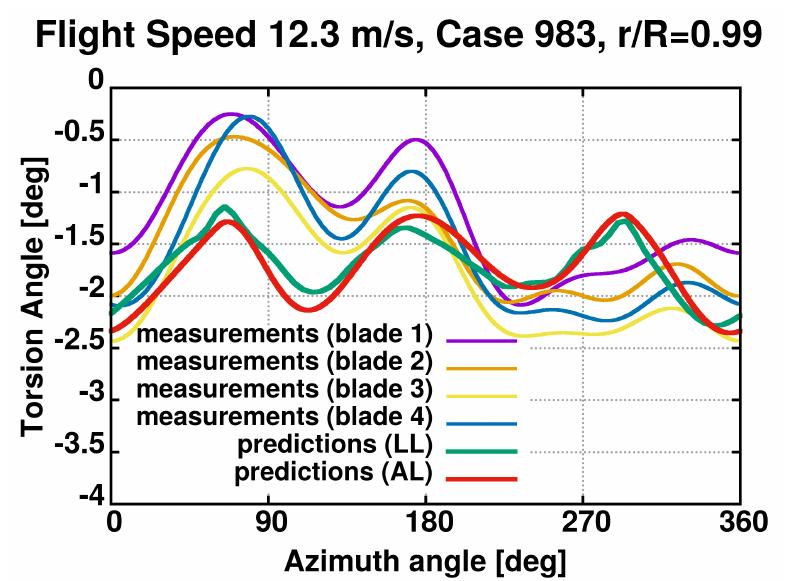
Figure 41. Forward flight at 12.3 m/s, case 983. Torsion angle at r / R =